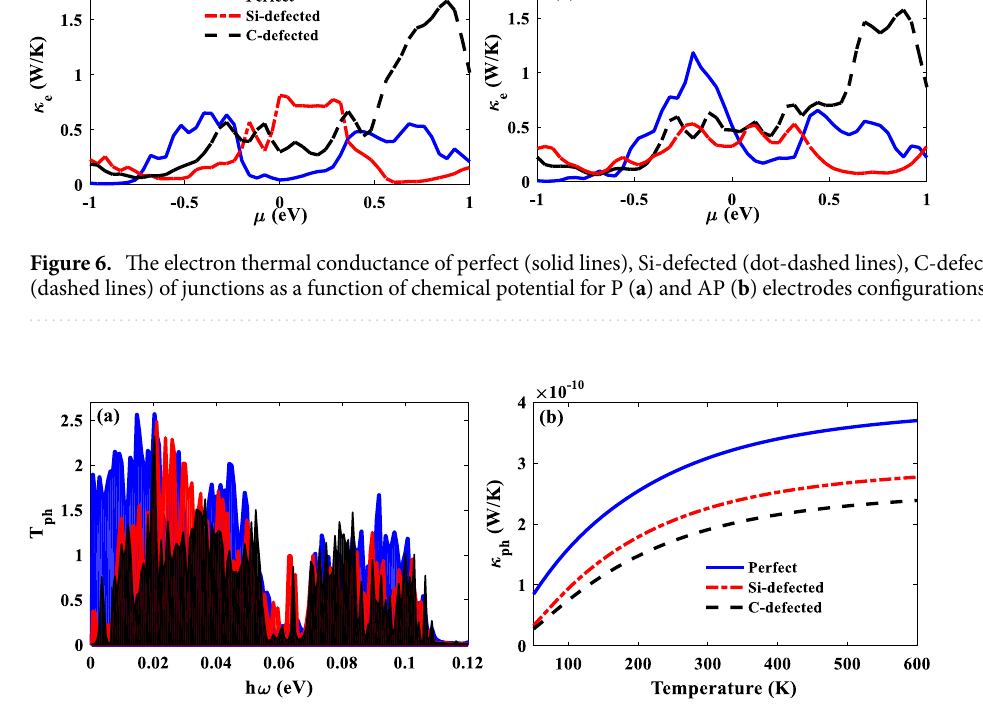
Figure 7. ( a ) The phonon transmission coefficient and ( b ) the phonon thermal conductance of the perfect (blue solid lines), the Si-defected (red dot-dashed lines) and the C-defected (black dashed lines) of junctions as a function of temperature